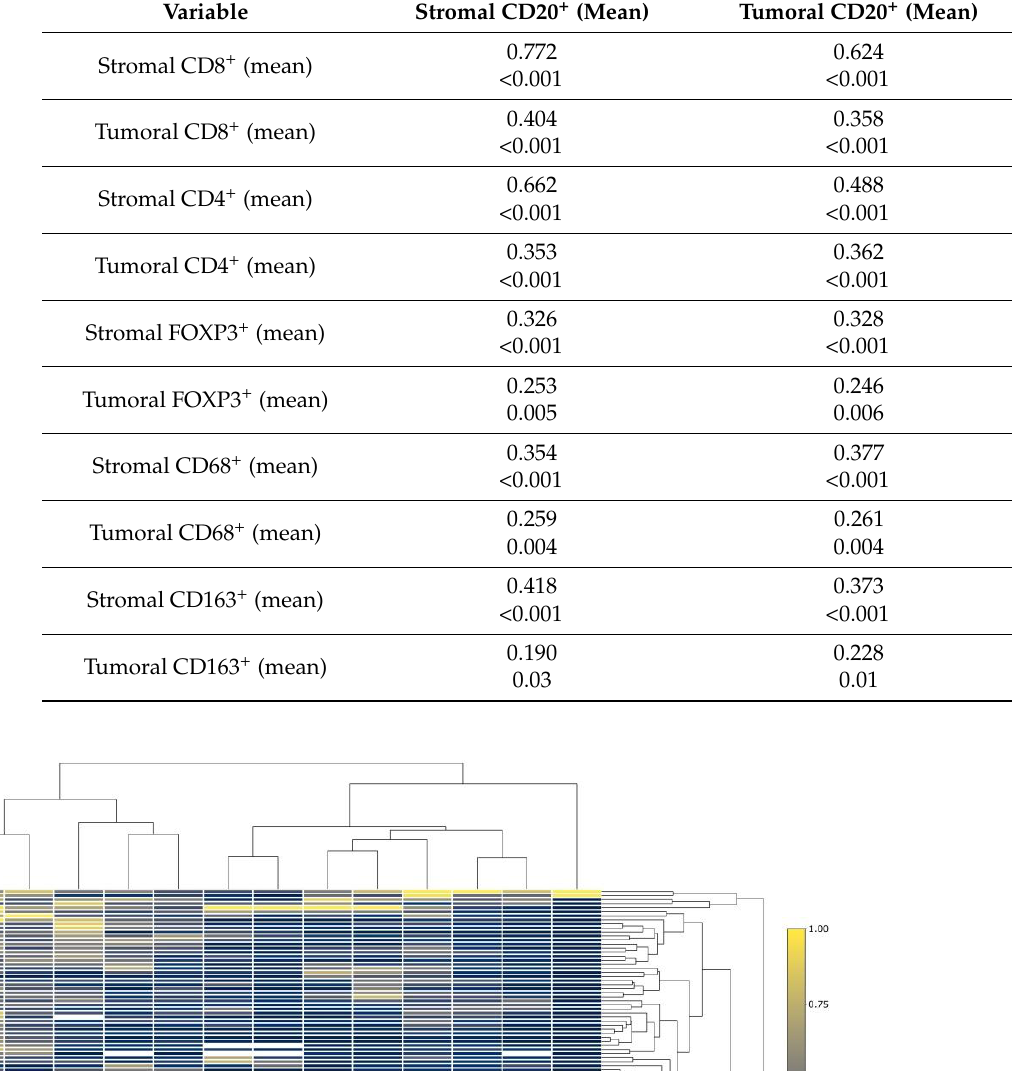
Table 1. Correlations between the mean numbers of CD20 + B cells with CD4 + , CD8 + , and FOXP3 + TILs, and CD68 + and CD163 + macrophages infiltrating both the tumor nests and surrounding stroma. The Spearman’s Rho coefficients and the corresponding p values are shown.